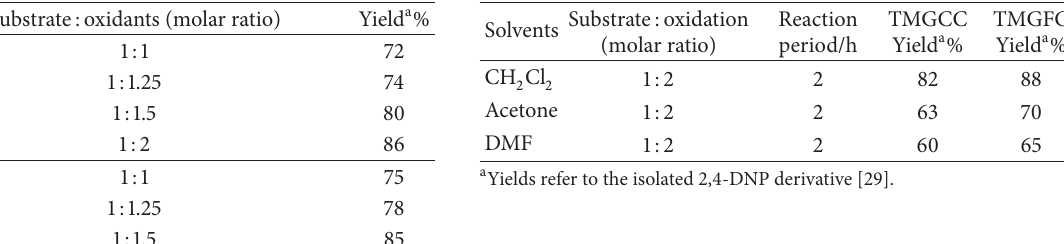
Table 2: Oxidation of benzyl alcohol in different solvents with TMGCC and